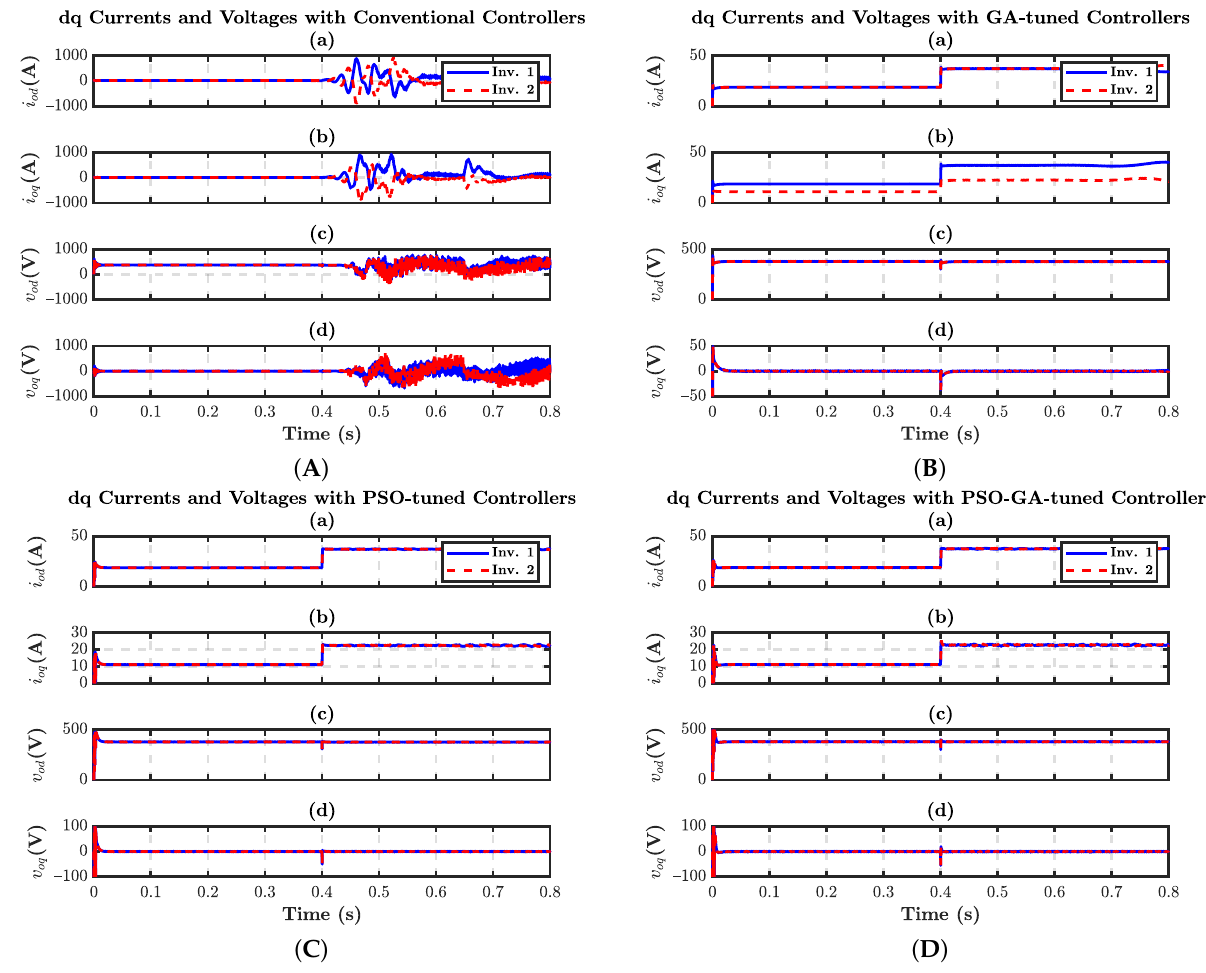
Figure 27. The dq -axis output currents and voltages in two-inverter MG: ( A ) conv.; ( B ) GA; ( C ) PSO; ( D ) PSO-GA. ( a ) d -axis current; ( b ) q -axis current; ( c ) d -axis voltage; ( d ) q -axis